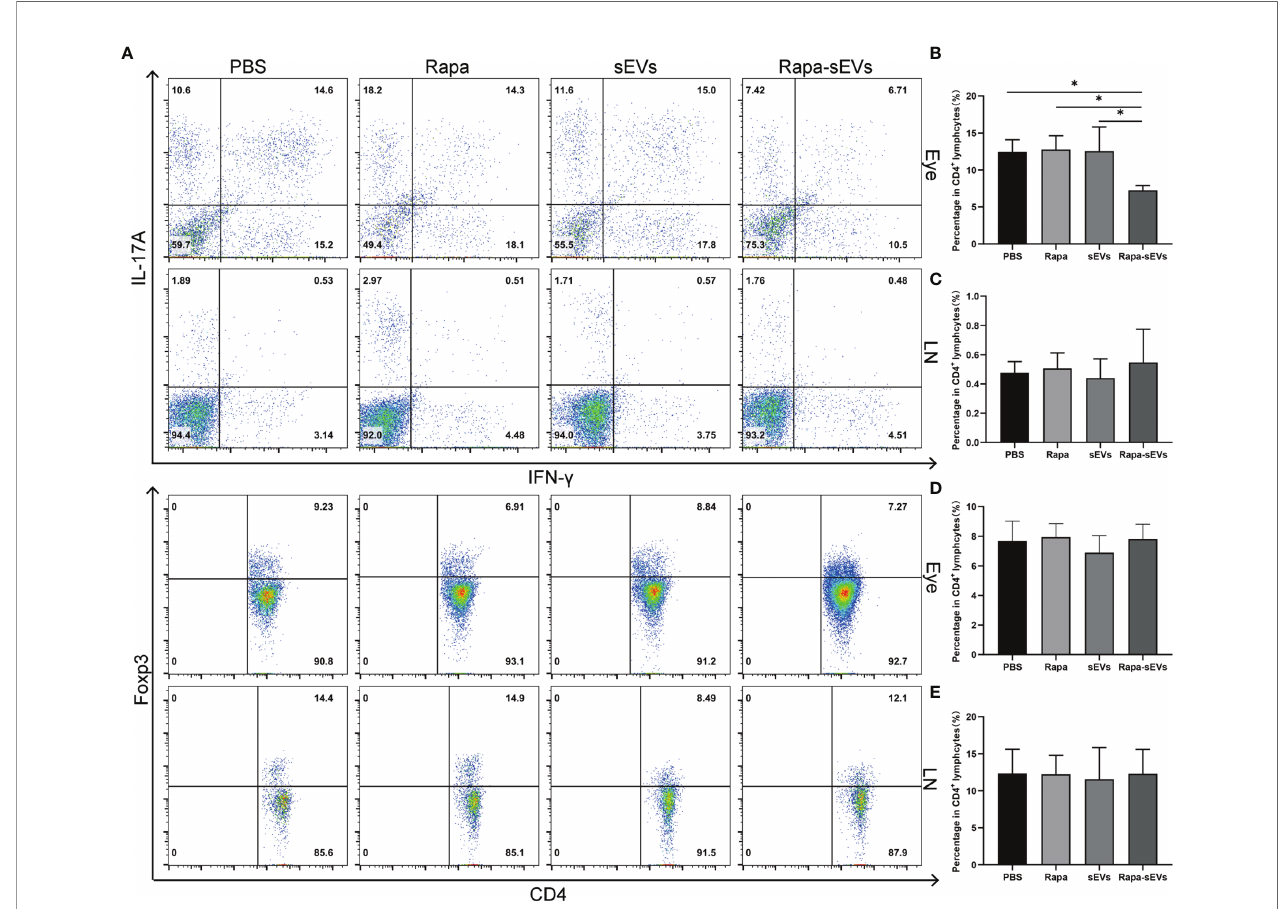
FIGURE 7 | Analysis of T cell subsets from eye and lymph node in EAU. (A) Representive fi gures of intracellular staining of IFN- g + IL-17 + , Foxp3 + in eyes and lymph nodes derived CD4 + T cells from PBS, Rapa, sEV, and Rapa-sEV treated mice with EAU. (B) The percentage of CD4 + IFN- g + IL-17 + cells in eyes. (C) The percentage of CD4 + IFN- g + IL-17A + cells in cervical draining lymph nodes. (D) The percentage of CD4 + Foxp3 + cells in eyes. (E) The percentage of CD4 + Foxp3 + cells in cervical draining lymph nodes. Values are expressed as the mean ± SD of three mice per group. *P < 0.05, one-way